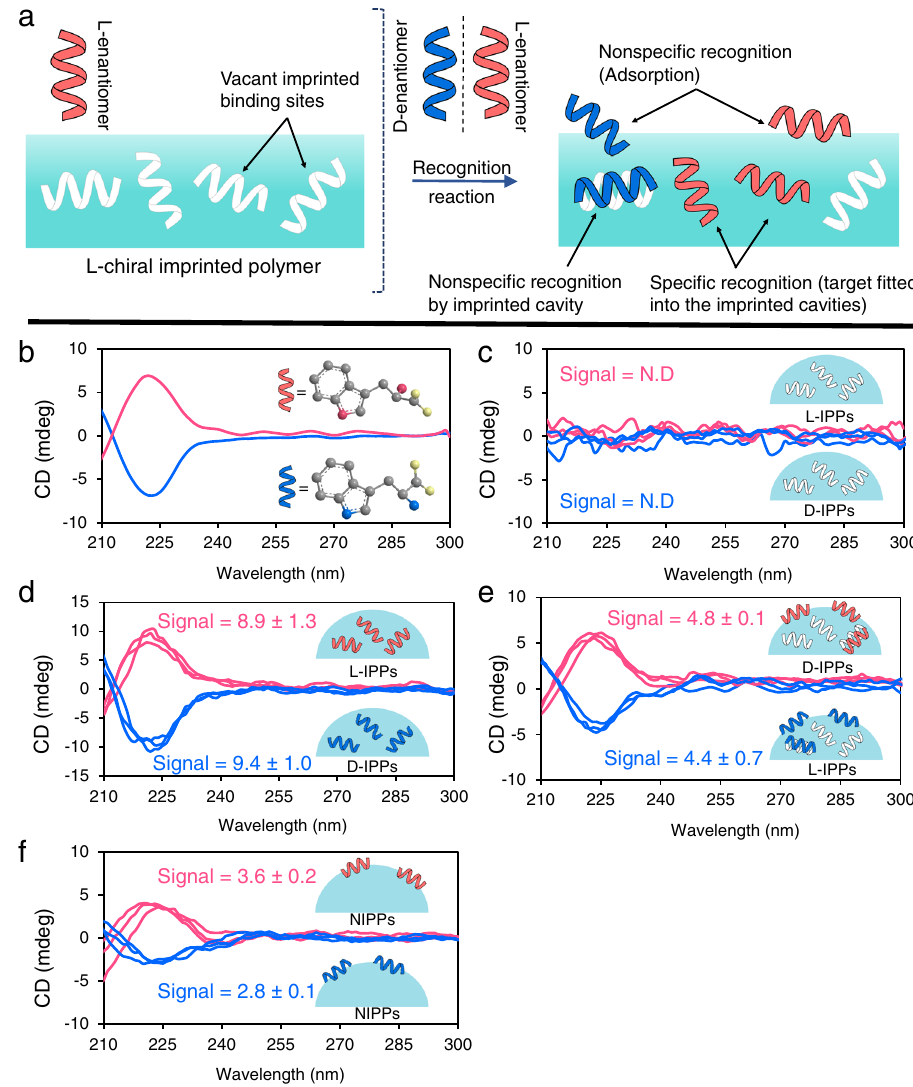
Fig. 2 | Study ofnon-speci fi c recognitiononthe CIS.a Status ofchiralmolecules and imprinted cavities of CISs after a recognition event. CD spectra of b standard solution of L -tryptophan and D -tryptophan, c L -IPPs and D -IPPs, d L -IPPs and D -IPPs afterrecognitionof L -tryptophanand D -tryptophan,respectively, e L -IPPsand D -IPPs after recognition of D -tryptophan and L -tryptophan, respectively, f NIPPs after